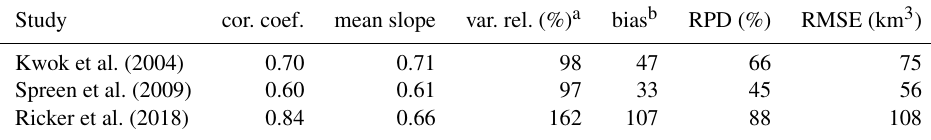
Table 2. Statistics of monthly PIOMAS versus satellite-based estimates of the sea ice volume fluxes through Fram Strait: Pearson correlation coefficient (cor. coef.), variance relative to PIOMAS (var. rel.), bias, relative percentage difference (RPD), and root-mean-square error (RMSE).